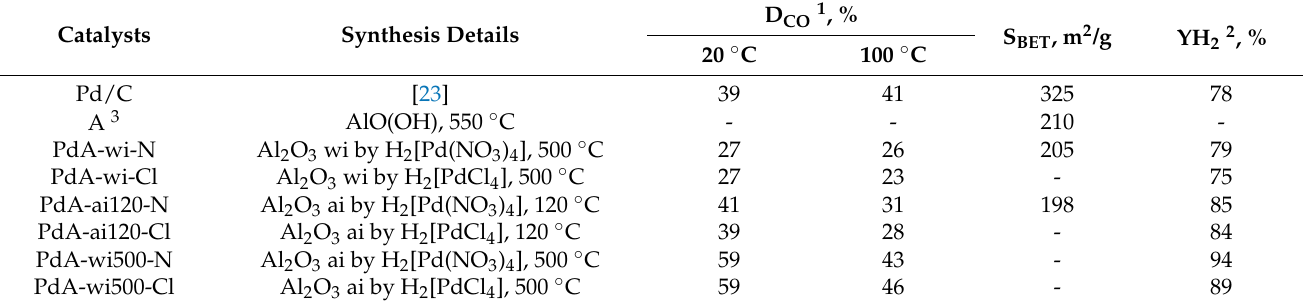
Table 1. Characteristics of palladium-containing catalysts and activity in dehydrogenation of